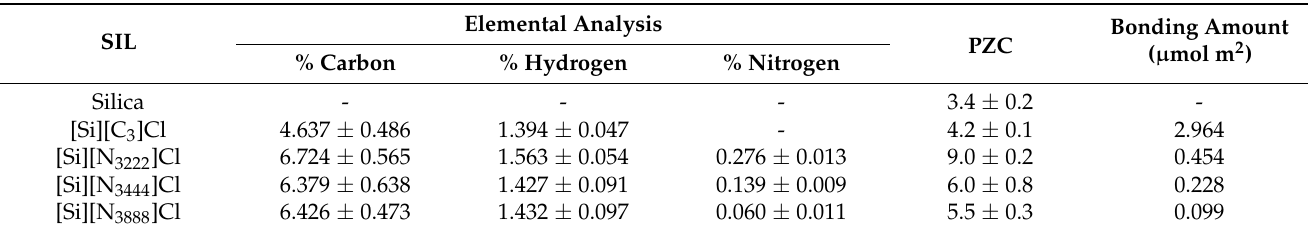
Table 1. Percentage weight fraction of carbon, hydrogen, and nitrogen obtained by Elemental analysis, along with the PZC and bonding amount for silica, [Si][C 3 ]Cl, and the three SILs [Si][N 3222 ]Cl, [Si][N 3444 ]Cl, and [Si][N 3888 ]Cl. Elemental Analysis